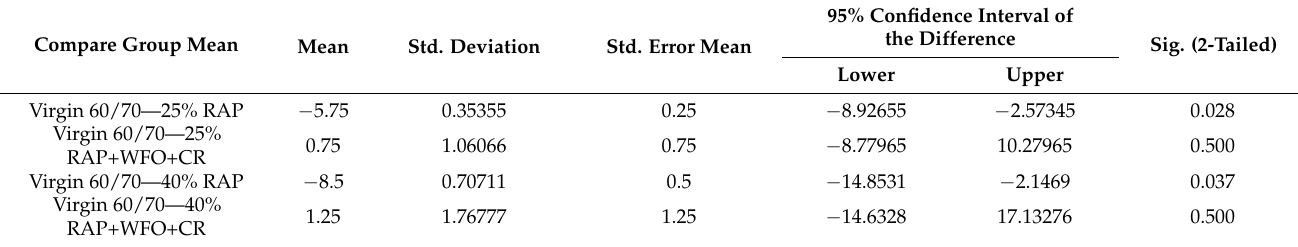
Table 5. Comparison of significant difference of group means for the softening point